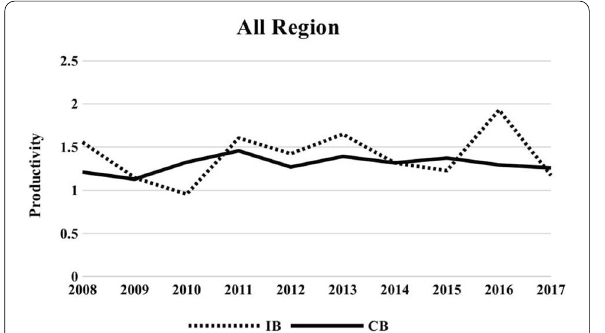
Fig. 8 Levels of productivity in South Asia